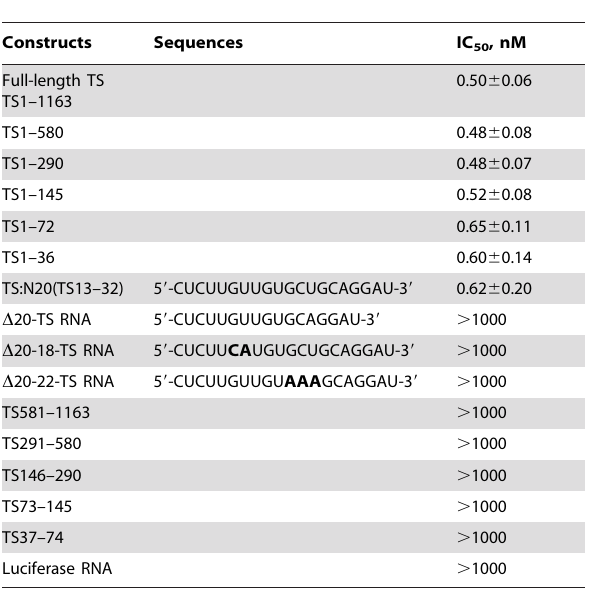
Table 1. Relative binding affinity of TS RNA constructs.